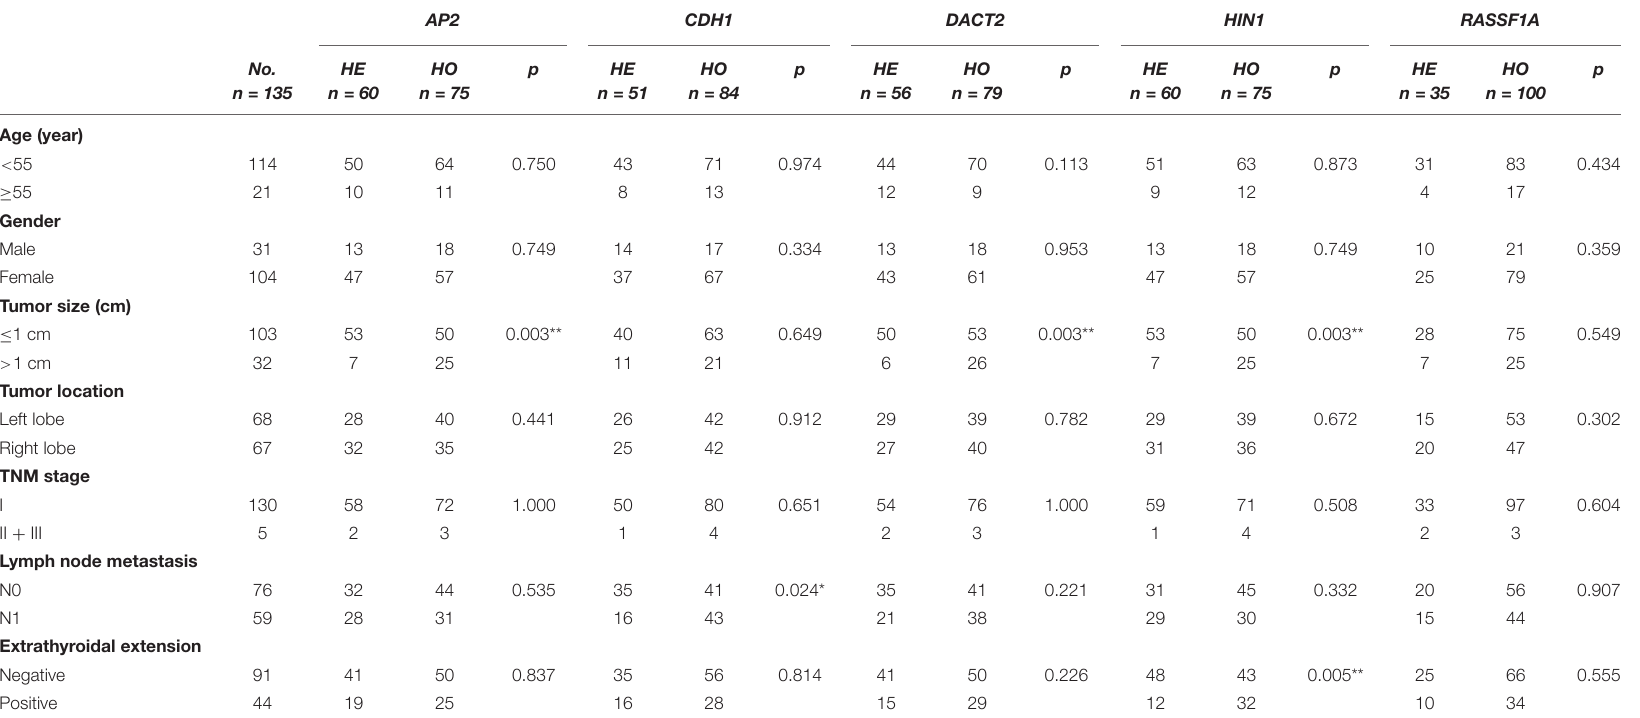
TABLE 3 | The association of methylation heterogeneity and clinical